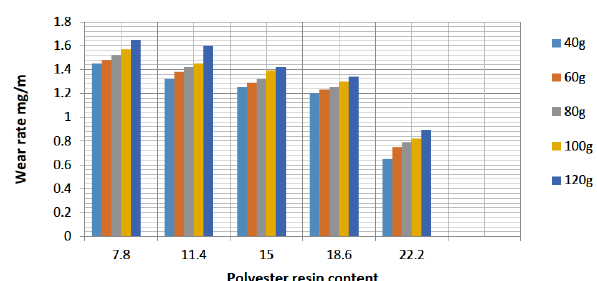
Figure 5: Rockwell Hardness values of PKS & CNS / Polyester com- posites for 250 µ m sieve size